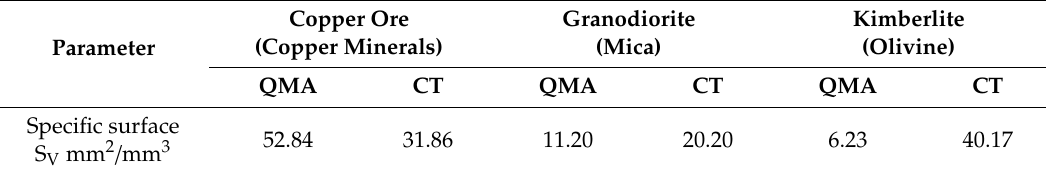
Table 3. Comparison of the specific surface of minerals obtained with QMA and CT.